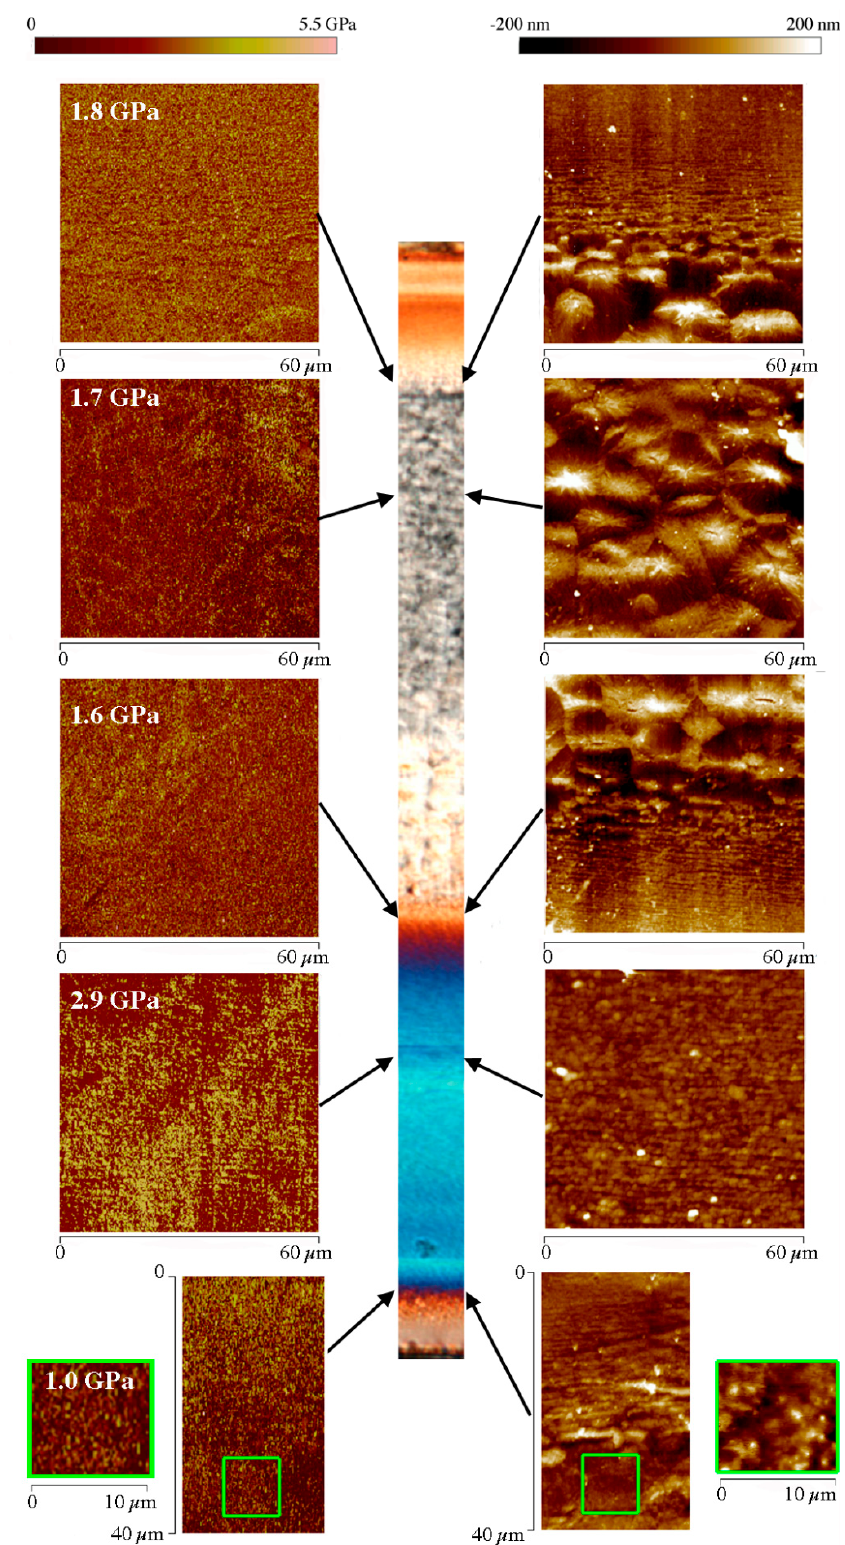
Figure 5. Atomic force microscopy (AFM) maps, height and modulus, obtained in different zones along the sample thickness, for the sample 120-8. The average moduli are reported in the map of each zone. Polarized Optical Microscopy (POM) micrographs and AFM maps have all the same alignment with flow direction in the thickness plane.